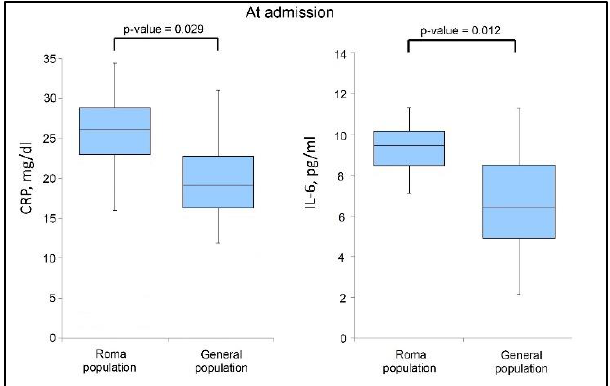
Figure 1. Boxplot of significant findings in biological parameters at admission.